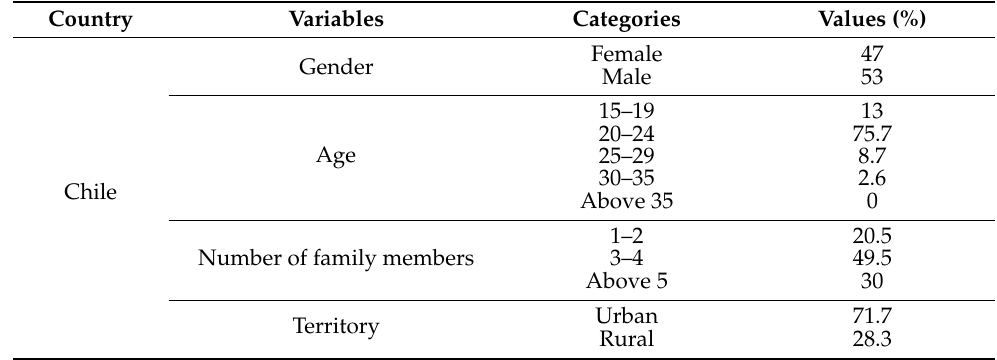
Table 2. Participant